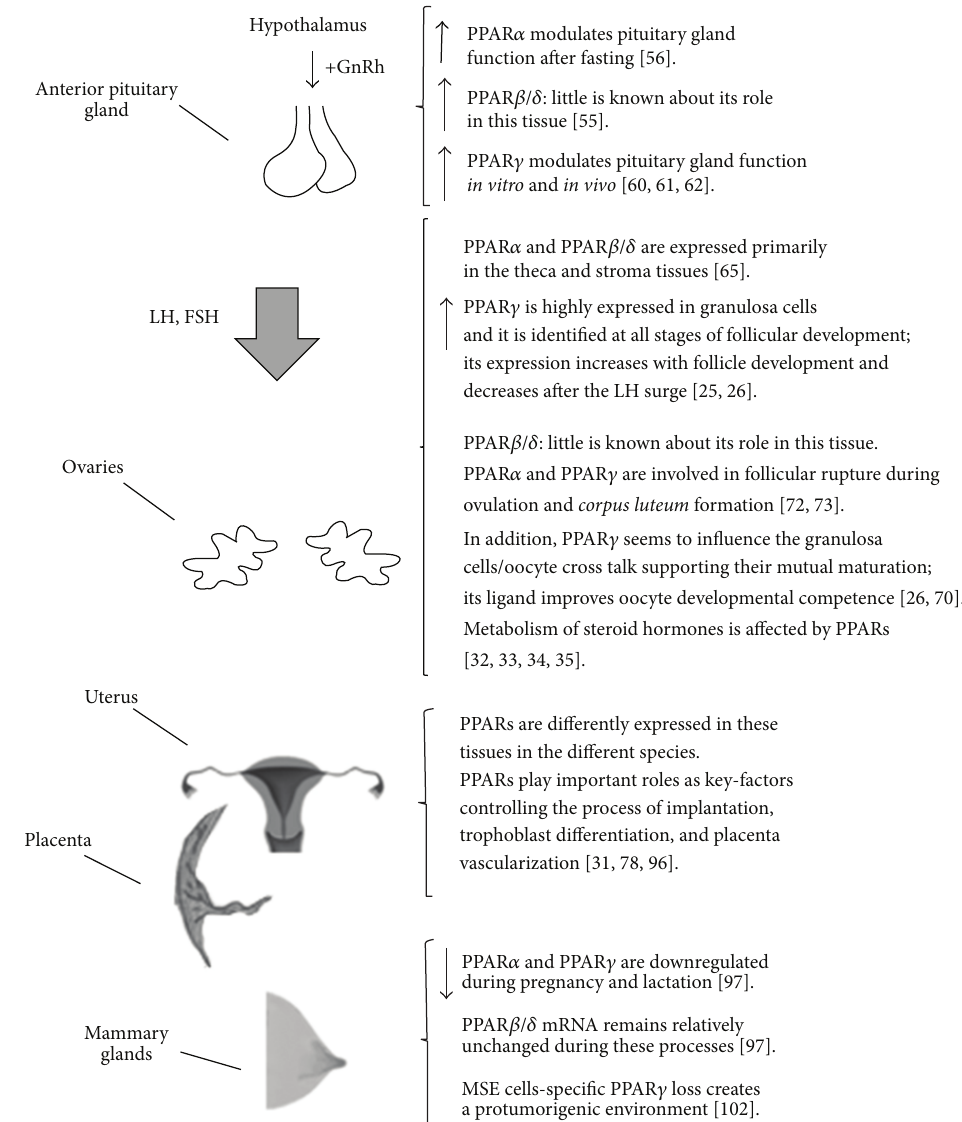
Figure 1: PPARs expression and role in the whole female reproductive